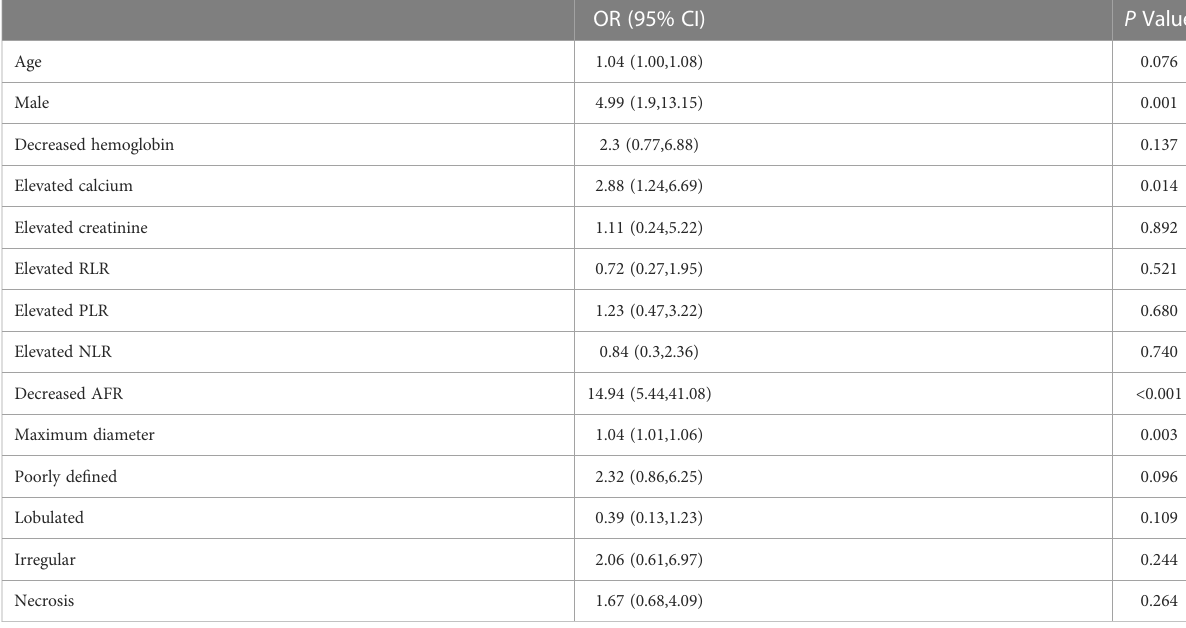
TABLE 3 Multivariate logistic regression analysis of clinicoradiological